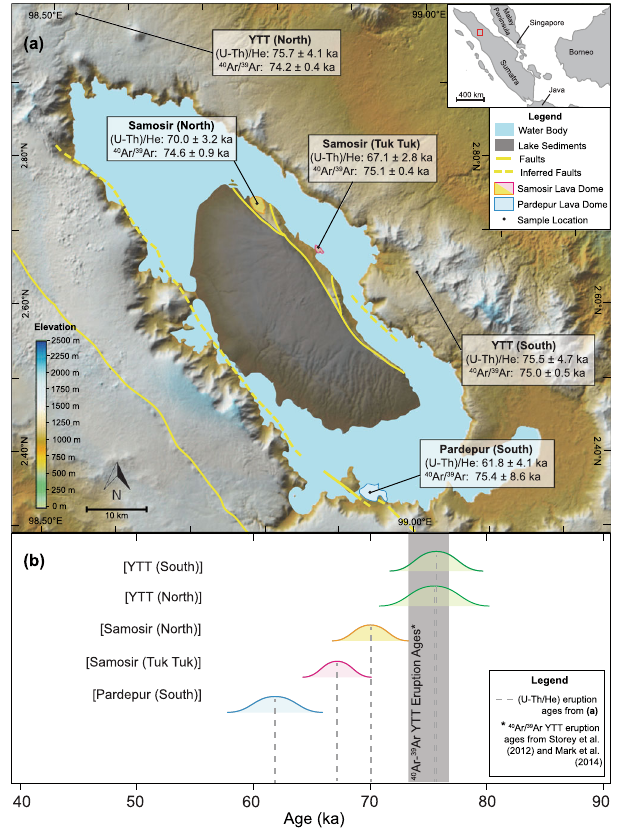
Fig. 1 Digital elevation map (ASTER 30 m) of Toba Caldera and post- Youngest Toba Tuff (YTT) resurgent lava domes, adapted from Mucek et al. 25 . a New error-weighted average Ar and recalculated zircon (U − Th)/He (ZHe) eruption ages from Mucek et al. 25 with ±2 σ are shown in boxes. Inset: geographical location of Toba Caldera in Southeast Asia shown outlined in red box. b Gaussian curves of recalculated error- weighted average ZHe ages from post-climactic eruptions at Toba Caldera. The Youngest Toba Tuff (YTT) was analyzed as an internal secondary standard both for ZHe and Ar dating (See Supplementary Information for details). The colours of the samples correspond to colours in ( a ). See Supplementary Data 2 for the full data